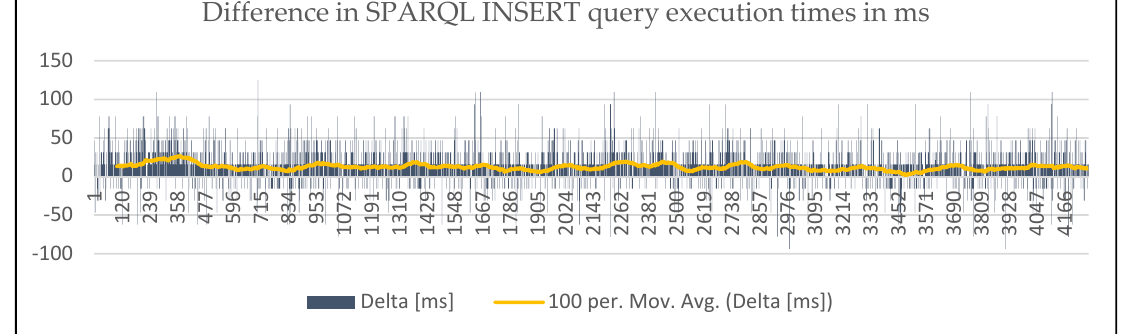
Figure 6. Di ff erence in SPARQ INSERT DATA query request execution times with moving